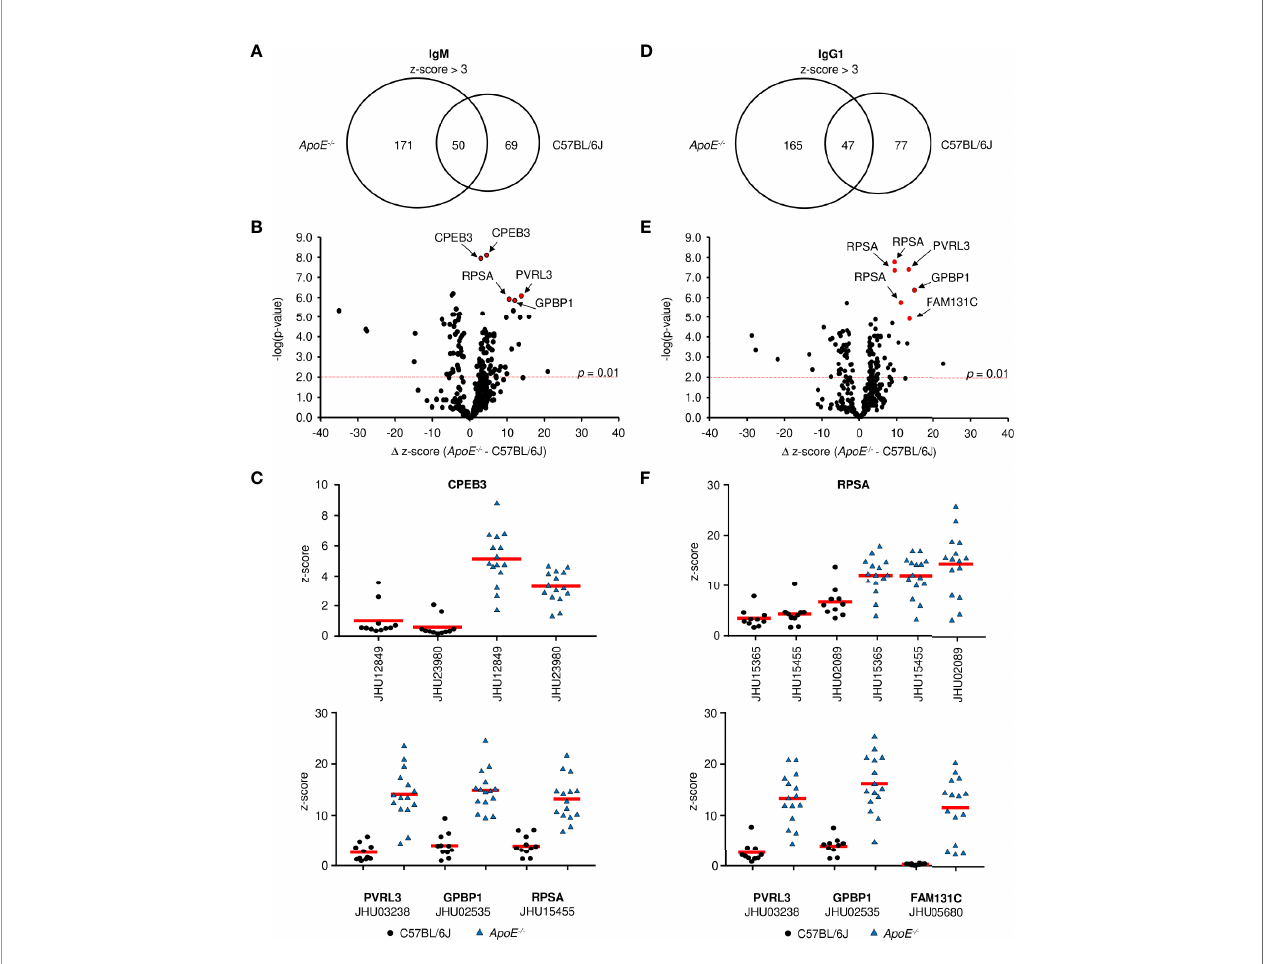
FIGURE 4 | Antigen identi fi cation in serum from ApoE -/- and C57BL/6J mice. (A, D) Venn diagrams showing the overlap of (A) IgM and (D) IgG1 antigen targets in ApoE -/- and C57BL/6J mice. Volcano plots examined the change in z-score between targets in ApoE -/- and C57BL/6J mice and the relative signi fi cance of those differences for (B) IgM and (E) IgG1. Red dashed line represents a p -value of 0.01 (two-tailed T-test). (C, F) Z-score values for representative antigens identi fi ed by red circles in (B, E) in all individual mice for (C) IgM and (F) IgG1. Values were calculated from 10 C57BL/6J and 15 ApoE -/- mice. Red solid line represents mean